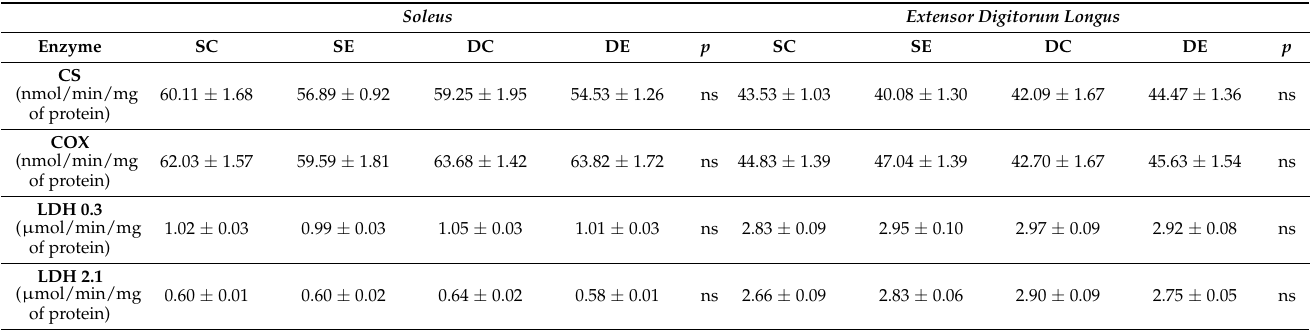
Figure 3. The effects of Dex treatment, swimming, and a combination of these factors on lipid metabolites level in rat plasma and skeletal muscles. Blood Triglycerides (Trigs) ( A ), Glycerol (Gly) ( B ), and Non-Esterified Fatty Acids (NEFA) ( C ) were measured in rats’ plasma. Soleus Trigs ( D ) and Gly ( E ), as well as EDL Trigs ( F ) and Gly ( G ), were measured in deproteinized muscle samples. There were significant differences between the groups: b p < 0.01, c p < 0.001 between the indicated groups; # p < 0.05, ## p < 0.01, and ### p < 0.001 between the indicated group and saline exercised group; ** p < 0.01, and *** p < 0.001 between the indicated and saline control groups. The data are presented as the means ± SEM ( n = 10 in each group). Table 2. The effects of Dex treatment, swimming, and a combination of these factors on activities of enzymes related to aerobic and anaerobic metabolism in skeletal